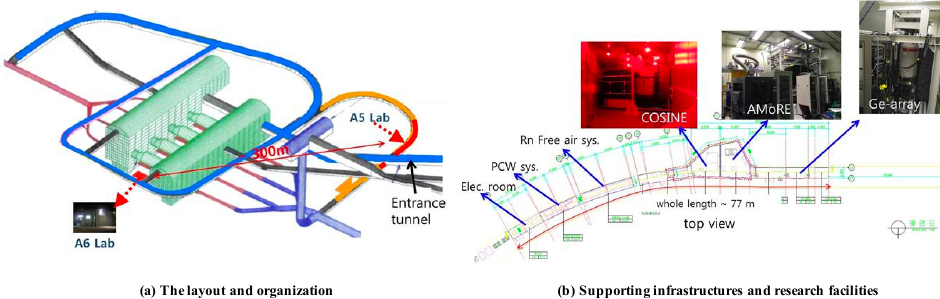
Figure 12. YangYang Y2L. ( a ) The layout and organization and ( b ) supporting infrastructures and experimental equipment